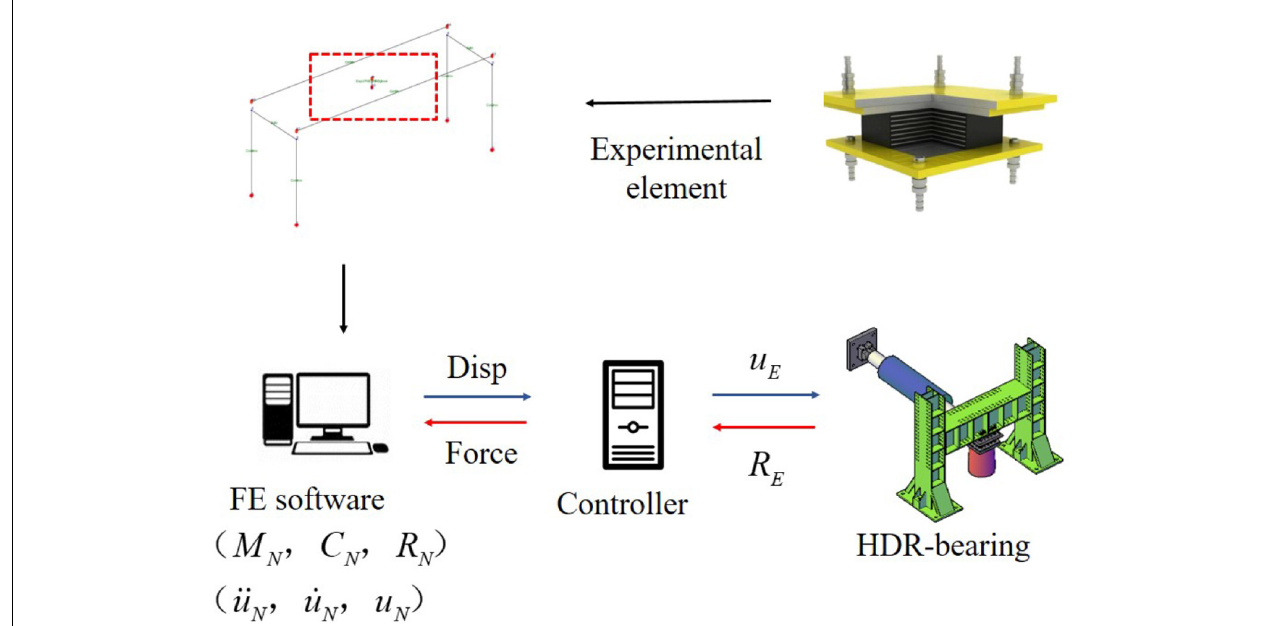
FIGURE 5 | Detailed representation of substructuring